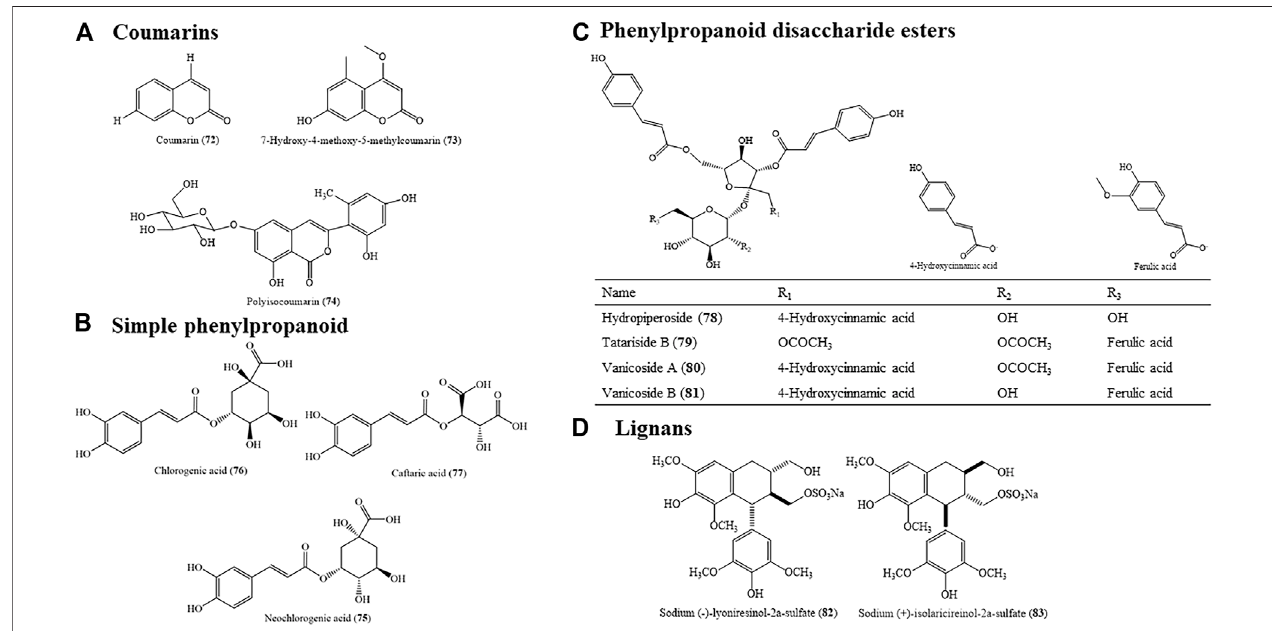
FIGURE6| Molecular structure ofphenylpropanoids: (A) coumarins, (B) simplephenylpropanoid, (C) phenylpropanoid disaccharideesters,and (D) lignansinHZ.